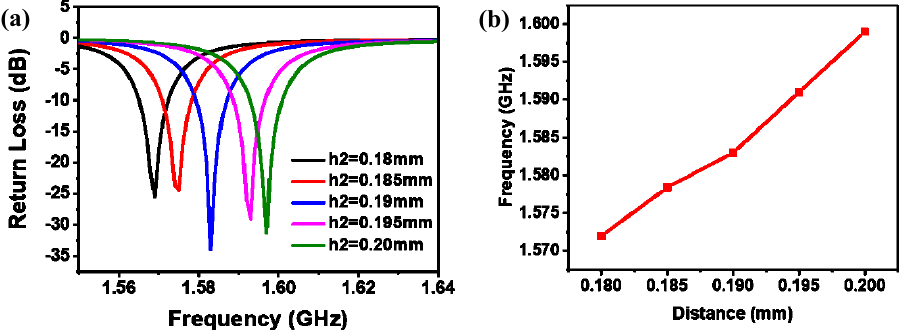
Figure 5. HFSS simulation optimization results. ( a ) The output curves corresponding to different cavity heights; ( b ) the variation curve of resonance frequency with cavity height.